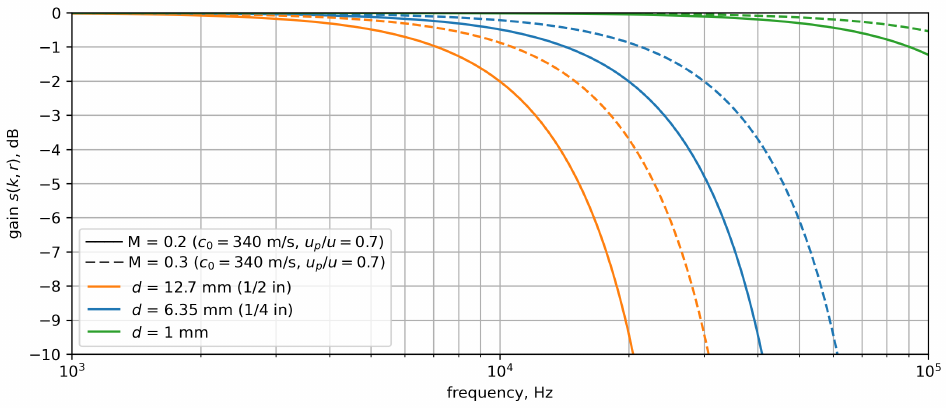
Figure 1. Modeled attenuation of hydrodynamic surface pressure fluctuations as a function of frequency at different Mach numbers and sensitive surface